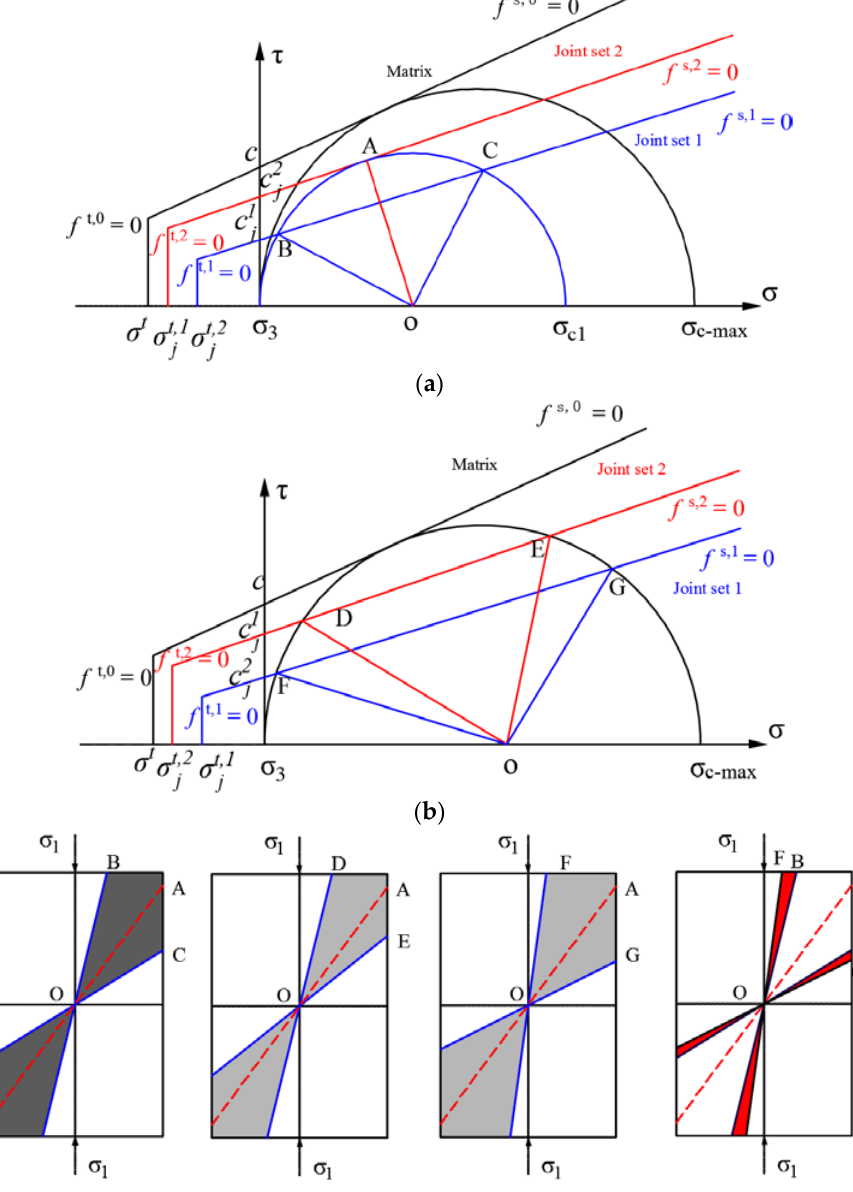
Figure 9. Failure areas for weak planes and rock matrix. ( a ) Increasing vertical stress reached a critical state for joint set 2; ( b ) Critical state for rock matrix and failure areas for weak planes; ( c ) Failure areas for weak planes and for rock matrix.